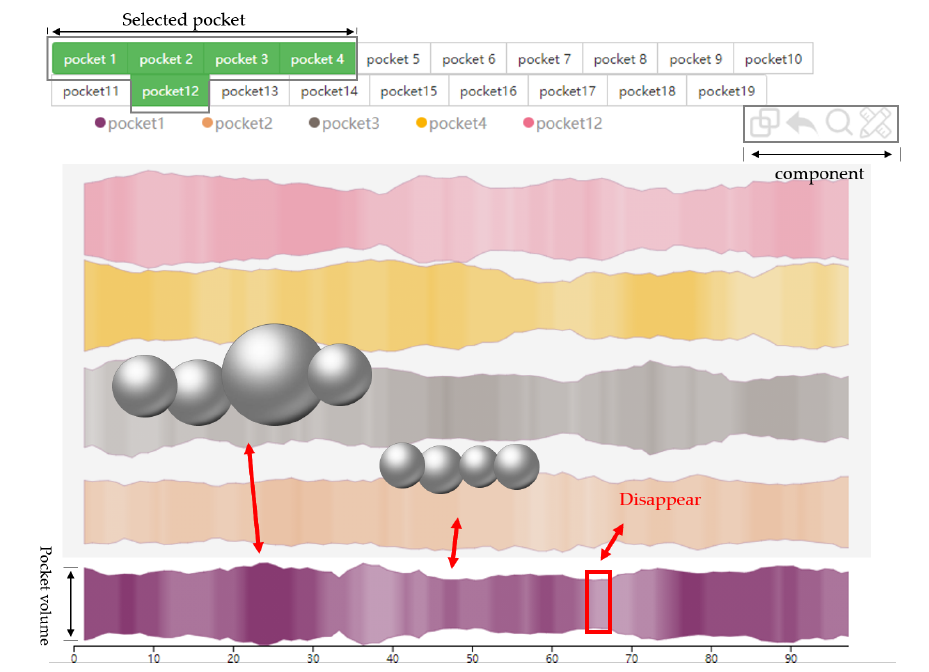
Figure 9. Pocket comparison view. The selected pockets are shown at the top and the component actions provided at the top right. Each river in the main image represents a single pocket, the change in width of the river indicates the change of pocket volume, and the change in transparency of the river indicates how often the pocket